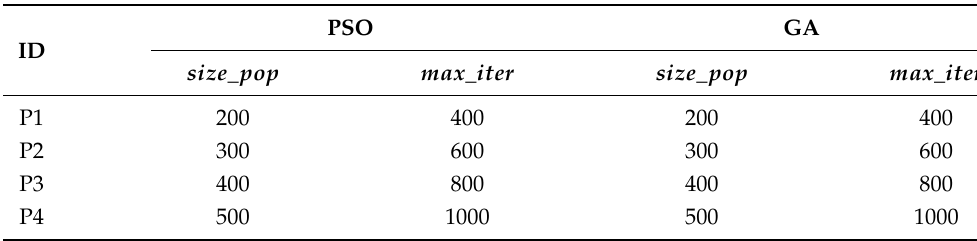
Table 4. Parameter settings for PSO and GA algorithms.